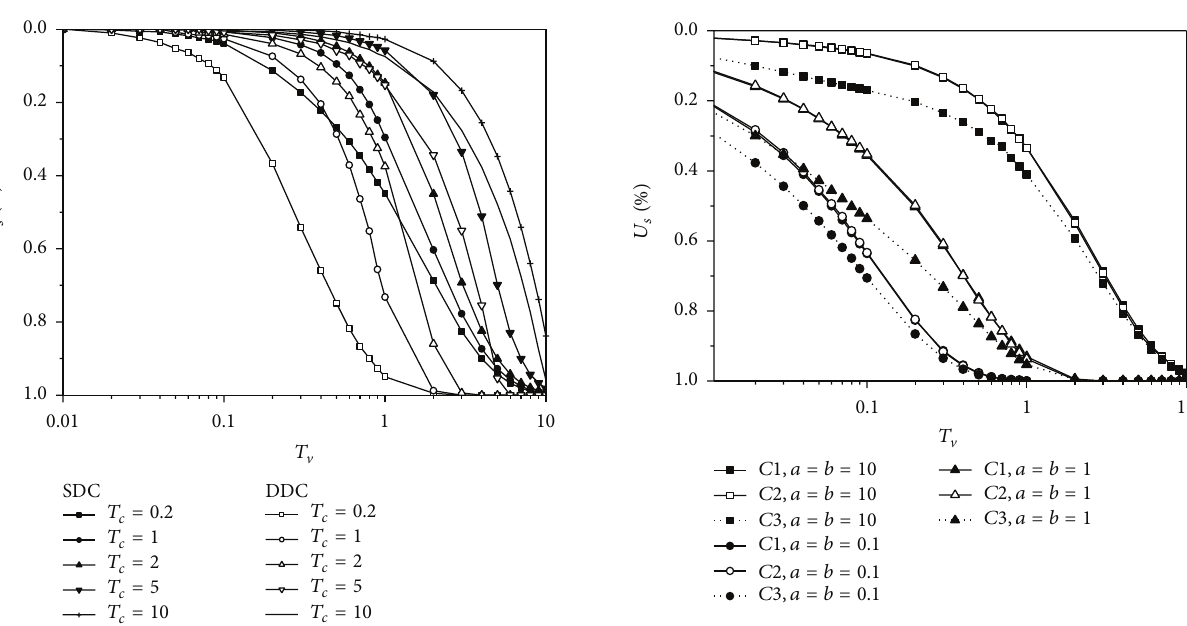
Figure 5: Degree of consolidation for different soil profiles.